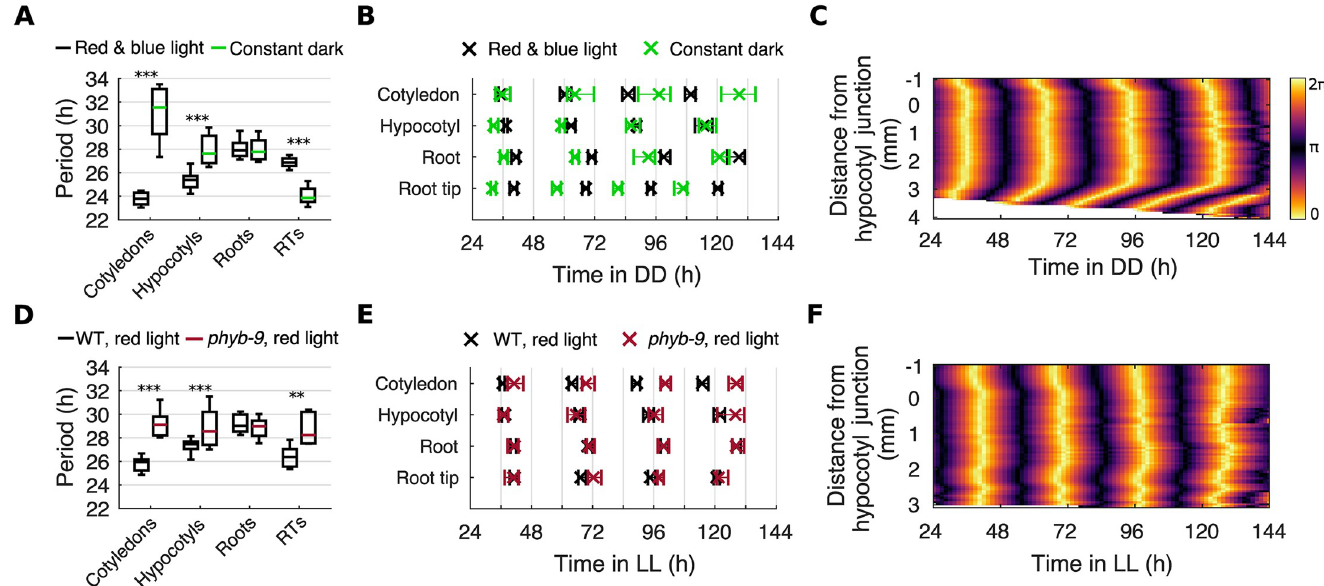
Fig 6. Local light inputs modulate the spatial coordination of the clock. (A) Period estimates for different organs under constant red and blue light or DD. ��� p < 0.001, by two-tailed t test, Welch correction. (B) Times of peaks of GI :: LUC expression in different organs under constant red and blue light or DD. Plots represent the 25th percentile, median, and the 75th percentile for the peak times of organs scored as rhythmic. (C) Representative phase plot of GI :: LUC expression across longitudinal sections of the hypocotyl and root of a single seedling under DD. (D) Period estimates of GI :: LUC for different organs under constant red light in the phyb-9 mutant. �� p < 0.01, ��� p < 0.001, by two-tailed t test, Welch correction. (E) Times of peaks of GI :: LUC expression in different organs under constant red light in the phyb-9 mutant. Plots represent the 25th percentile, median, and the 75th percentile for the peak times of organs scored as rhythmic. (F) Representative phase plot of GI :: LUC expression across longitudinal sections of the hypocotyl and root of a single seedling under constant red light in the phyb-9 mutant. For red and blue light data, N and n are as presented in Fig 2. For DD, N = 3; phyb-9 red light, N = 4. For all, n = 23–35. N represents the number of independent experiments and n the total number of seedlings. See S1 and S2 Files for exact n , test statistics, and percentage rhythmicity in each organ. Box plots indicate the median and upper and lower quartiles, and whiskers the 9th and 91st percentiles of organs scored as rhythmic. Underlying data are available from https://gitlab.com/slcu/teamJL/greenwood_ etal_2019. DD, constant darkness; GI , GIGANTEA ; LL, constant light; LUC , LUCIFERASE ; RT, root tip; WT, wild type.